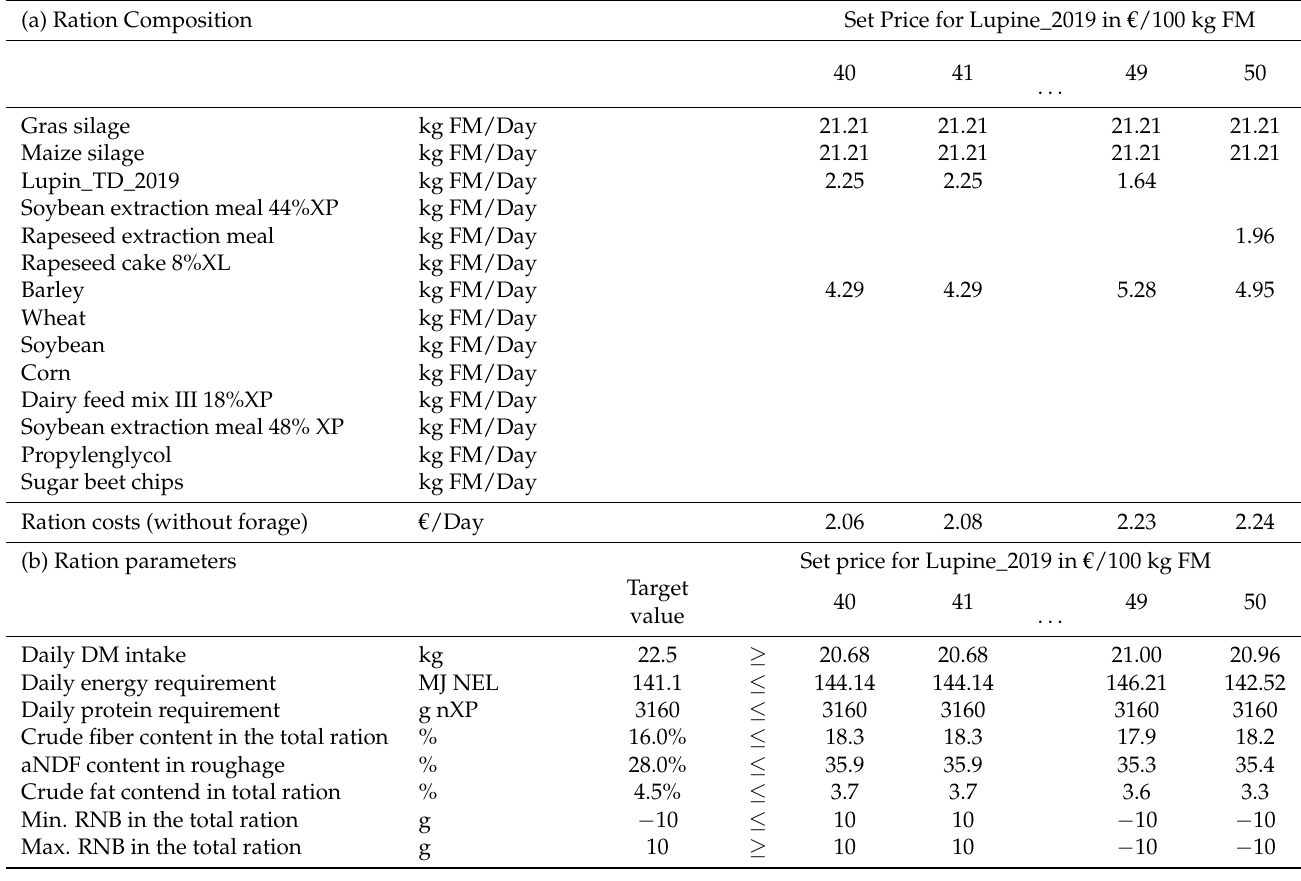
Table A2. Additional output for dairy cows (according to the input of Table